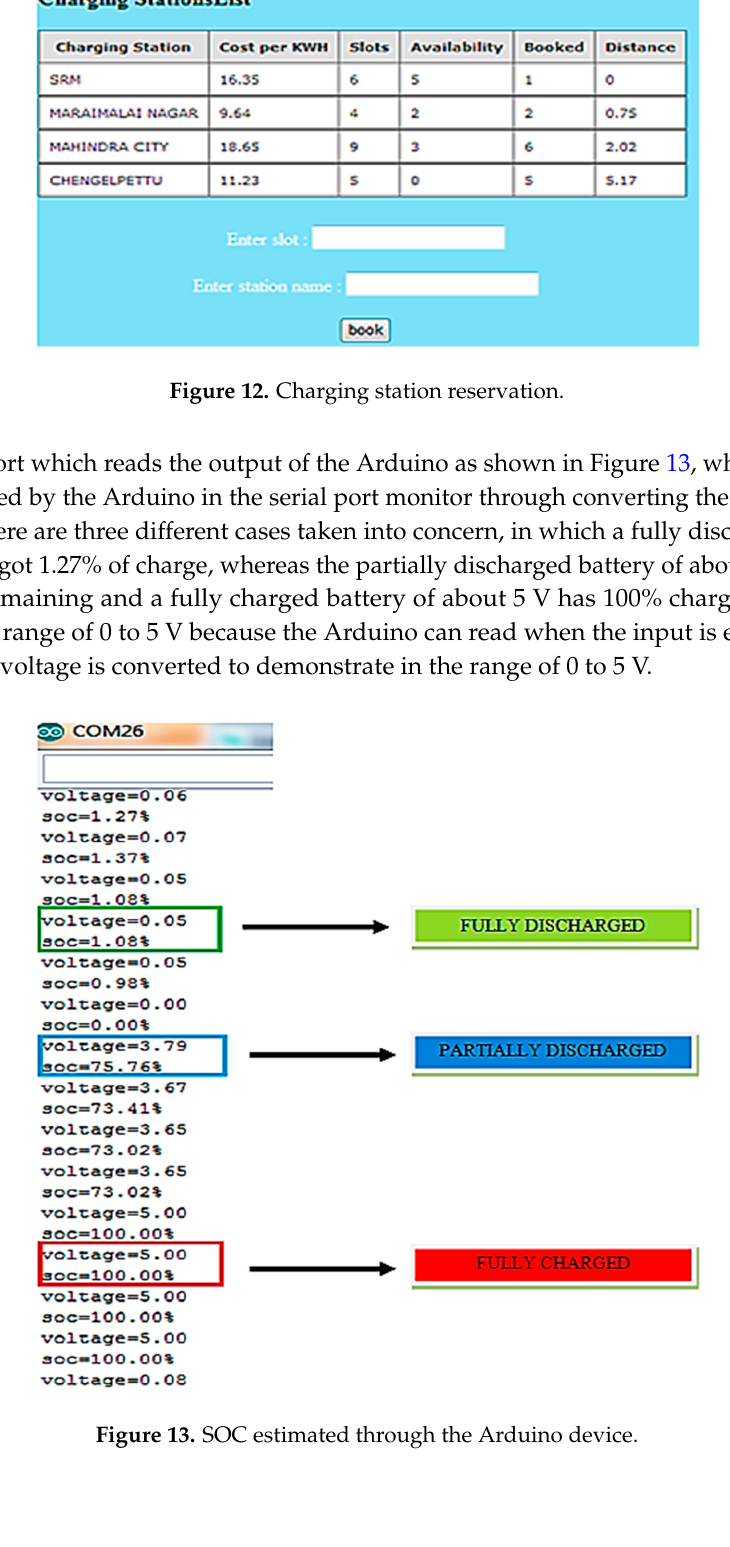
Figure 13. SOC estimated through the Arduino device.